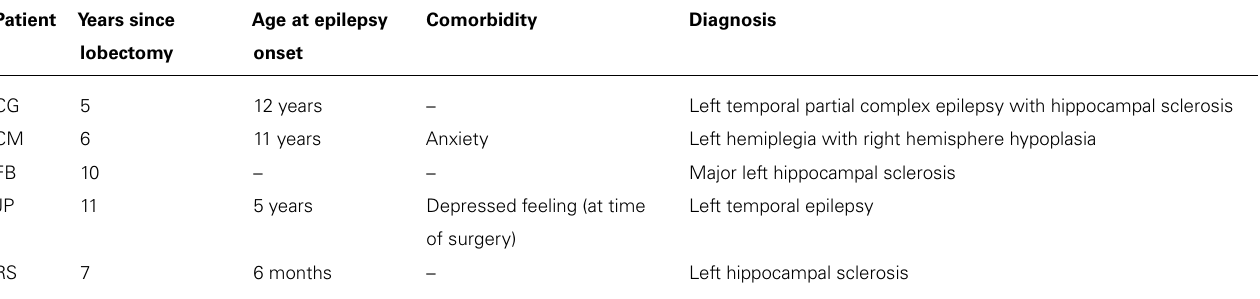
Table 2 | Patient